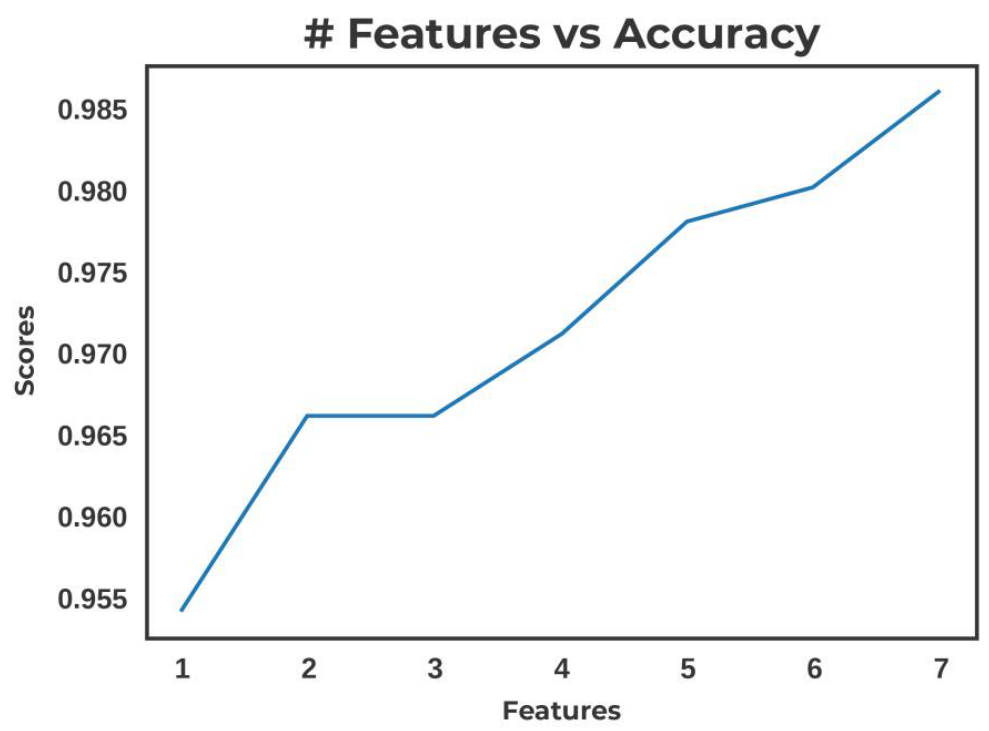
Figure 10. Features vs. Accuracy.